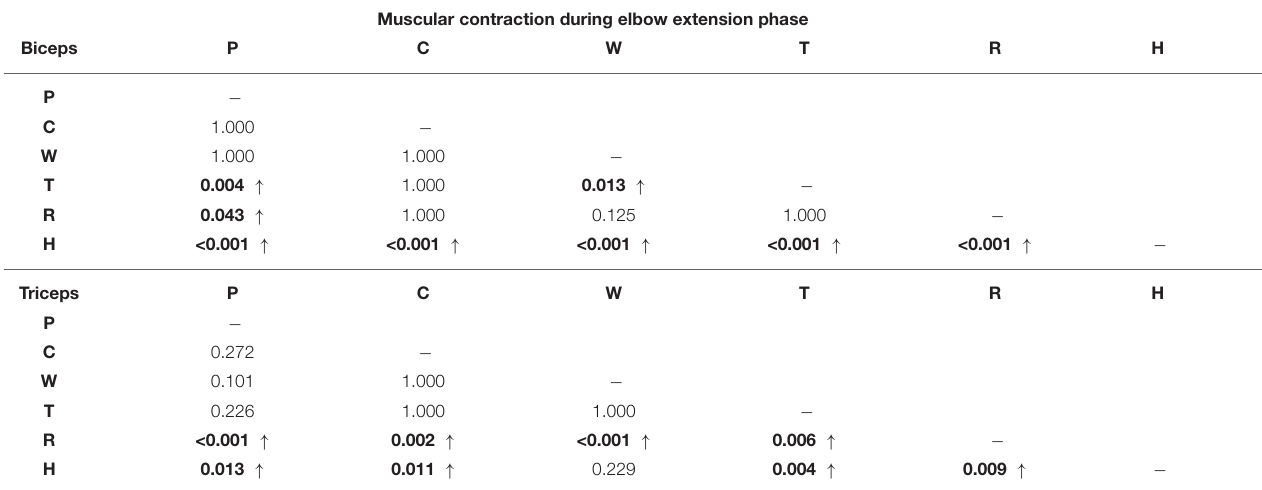
TABLE 4 | P -values results of the post-hoc analysis comparing iEMG index among training modalities during elbow extension